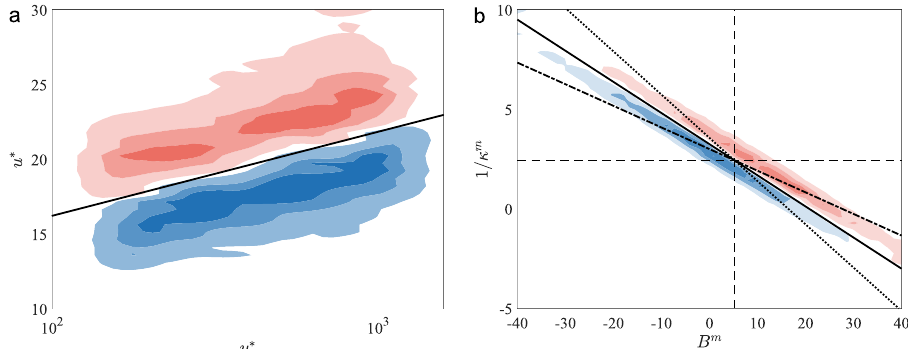
Fig. 2 State-action map of VWM and LLWM. a Probability density function of states u * for given y * for VWM conditioned to events with r > 0.1 and a < 0.95 (blue) or a > 1.05 (red). Contour levels are 30, 50, 70% of maximum value. Line indicates the log law u þ ¼ 1 = κ log y þ þ B with κ = 0.41, B = 5.2. b Joint probability density functions of states 1/ κ m and B m for LLWM conditioned to events with r > 0.1 and a < 0.95 (blue) or a > 1.05 (red). Contour levels are 30, 50, 70% of maximum value. Dashed lines indicate κ = 0.41, B = 5.2; the solid, dotted, and dot-dashed lines are ð 1 = κ m (cid:3) 1 = κ Þ log ð y þ Þ þ ð B m (cid:3) B Þ ¼ 0 for ð h m Þ þ ¼ 500, 100 and 10 4 ,